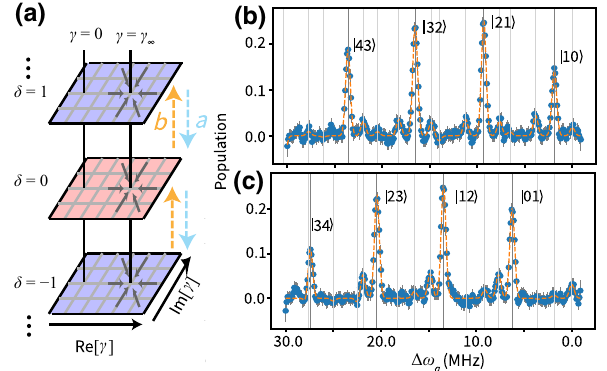
FIG. 3. The manifold of stabilized PCSs. (a) A conceptual representation of the different δ subspaces of the two-cavity sys- tem under pair-photon-driven dissipation. Each subspace has a unique steady state | γ ∞ , δ (cid:2) , which functions as an attractor in a generalized phase plane. In general, the system is stabilized to the manifold of states represented by the vertical string γ = γ ∞ . (b),(c) Ancilla spectroscopy that demonstrates the photon- number distribution of the stabilized (b) δ = 1 and (c) δ = − 1 PCSs. These measurements are performed by preparing initial states of | 10 (cid:2) and | 01 (cid:2) , respectively, and then applying the exact same stabilization drives as used in Fig. 2(c) for t = 15 µ s. For each plot, the dark vertical lines indicate the desired states while the light vertical lines mark error states due to single-photon loss or imperfect initial-state